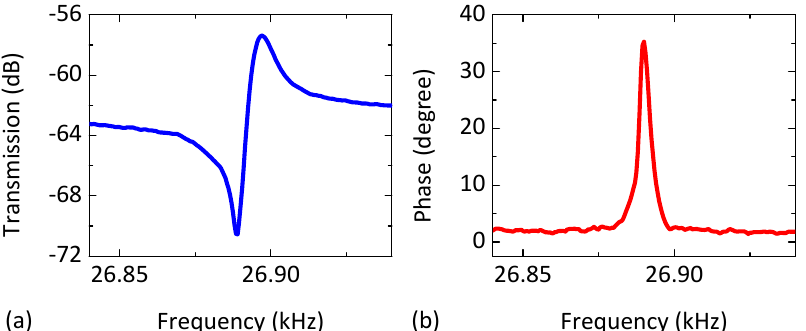
Figure 5. Electrical characterization results of the single-crystal SOI MEMS resonator. ( a ) Measured transmission (dB) and frequency response of the resonance; ( b ) Open-loop phase (degrees) around the first mode for V DC = 20 V and an input power of − 10 dBm.